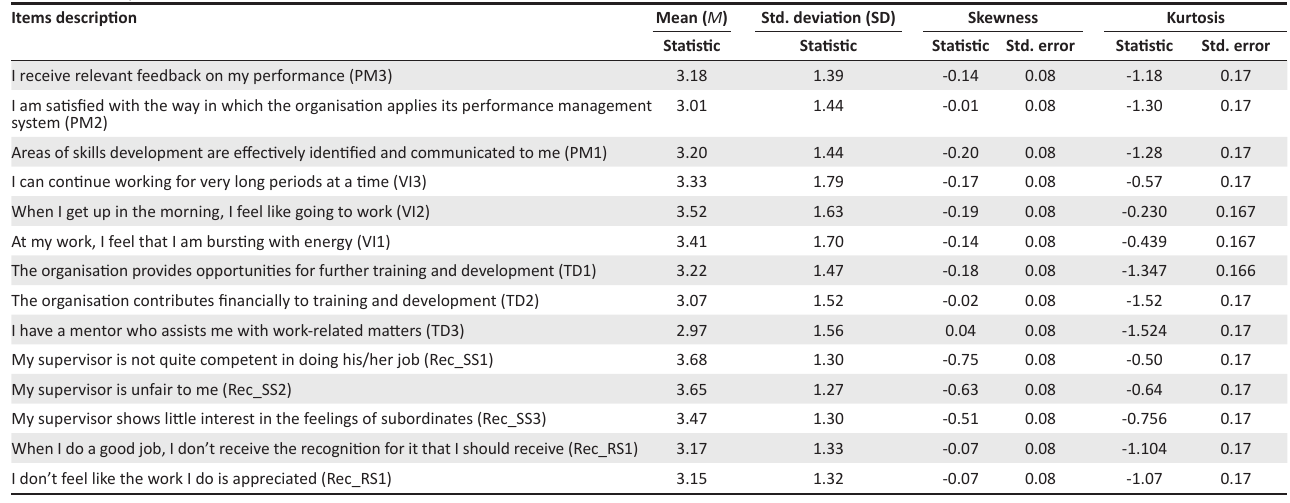
TABLE 2: Descriptive statistics.